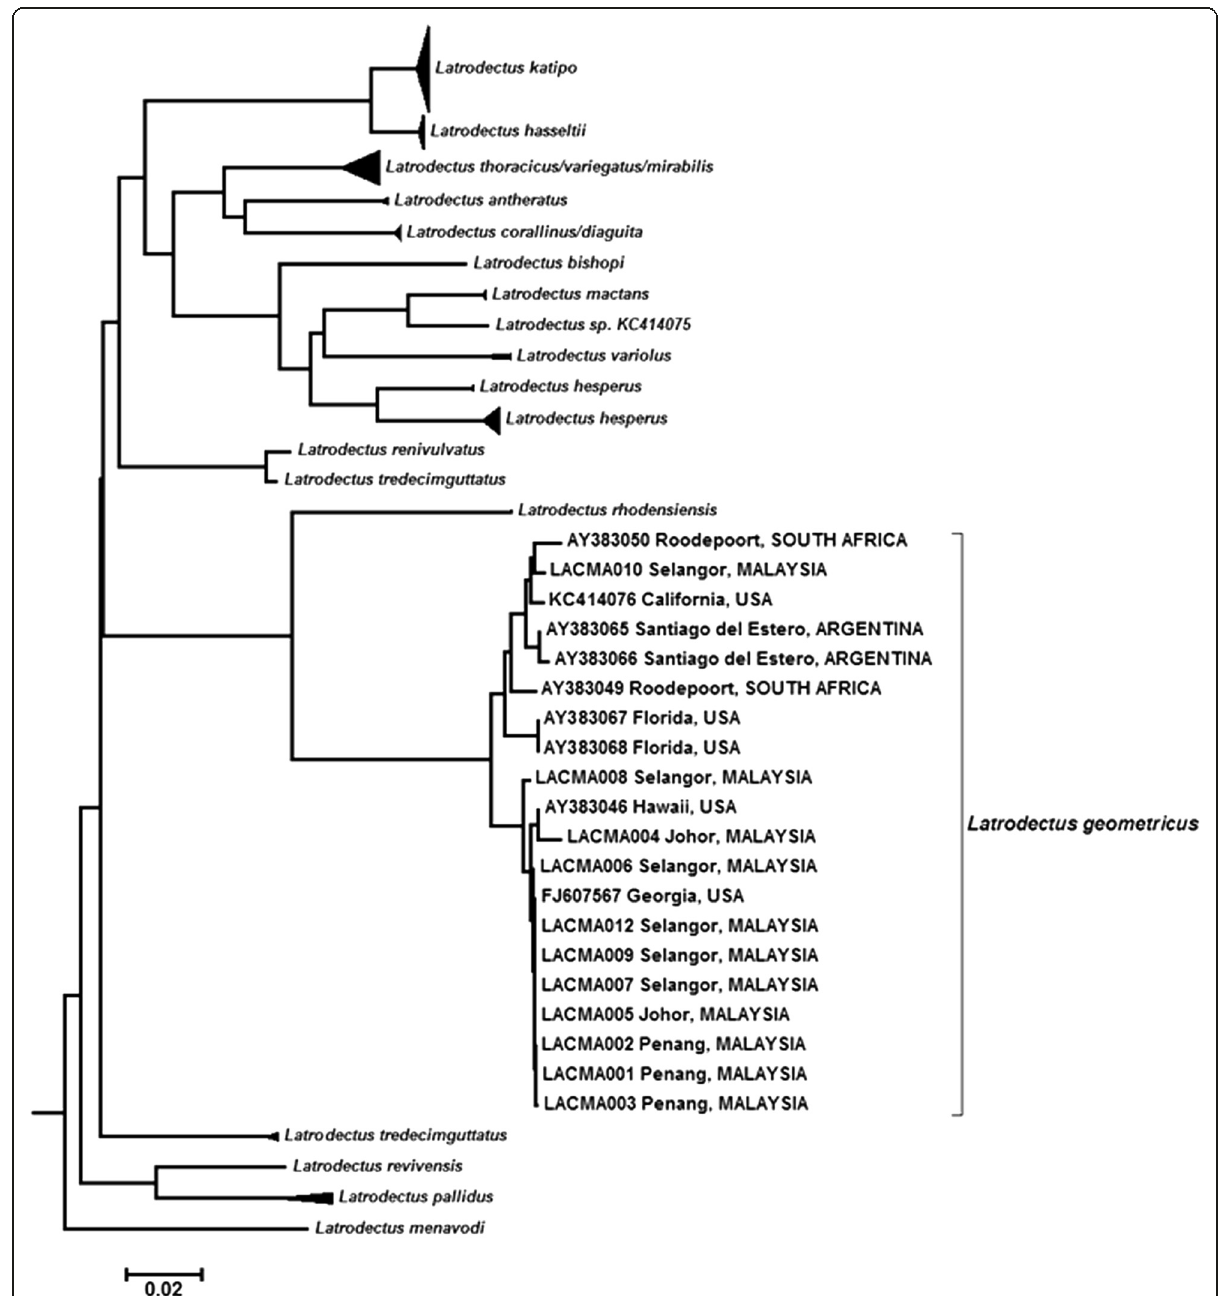
Figure 3 Neighbor-joining tree showing K2P distances between newly sequenced DNA barcodes from spiders collected in Peninsular Malaysia (codes: LACMA00XX) and publicly available sequence data for Latrodectus geometricus collected worldwide (GenBank accession numbers by